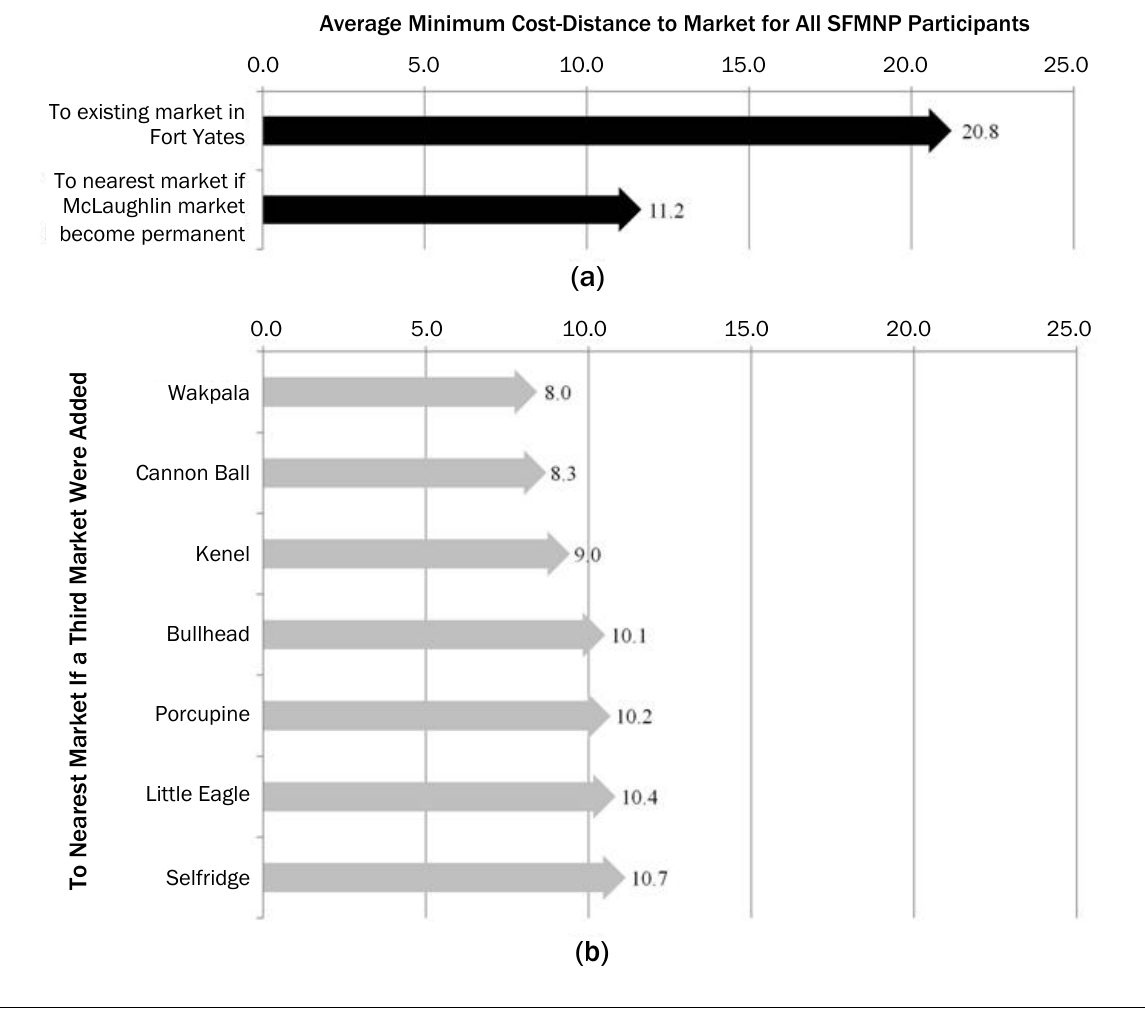
(a) Making the existing market in McLaughlin permanent results in a substantial reduction of average minimum cost-distance. (b) Adding a subsequent third market yields further reductions; as a single third market, Wakpala would reduce the average minimum cost-distance the